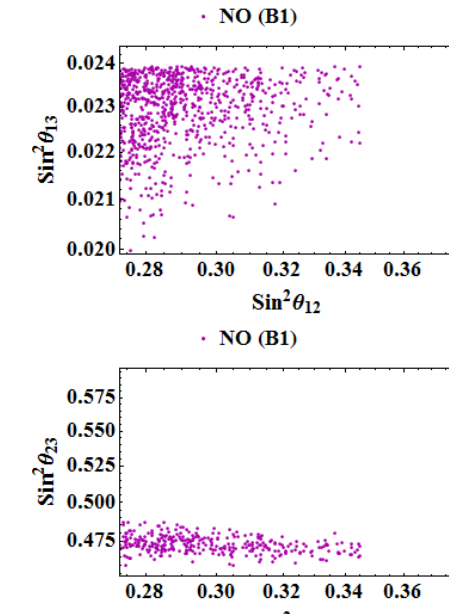
JHEP06(2019)064